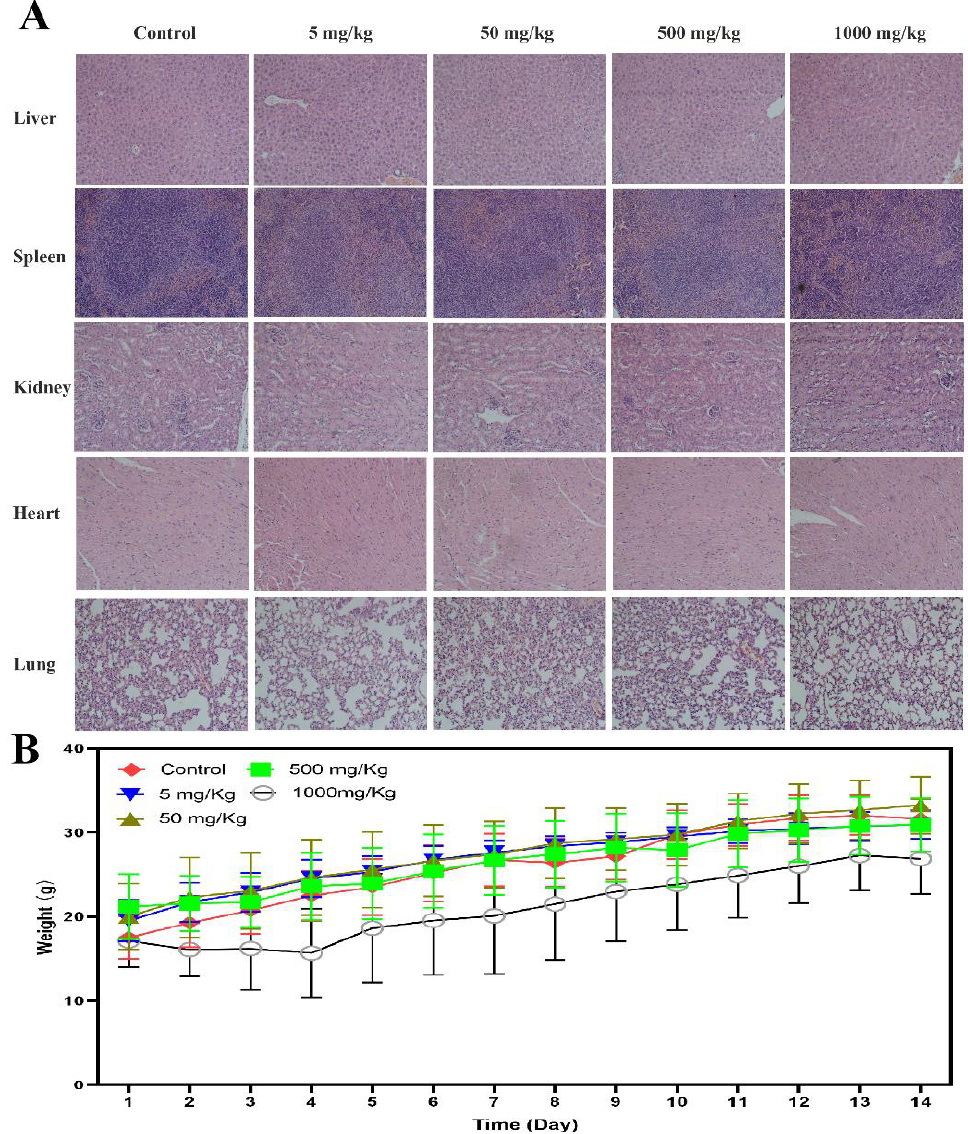
Figure 7. HE staining was used to observe the change of liver, spleen, kidney, heart, and lung after treatment with BLG26. ( A ) BLG26 treatment caused moderate edema in the liver of 1000 mg/kg group. ( B ) Body weight changes in mice during 14 days of observation.